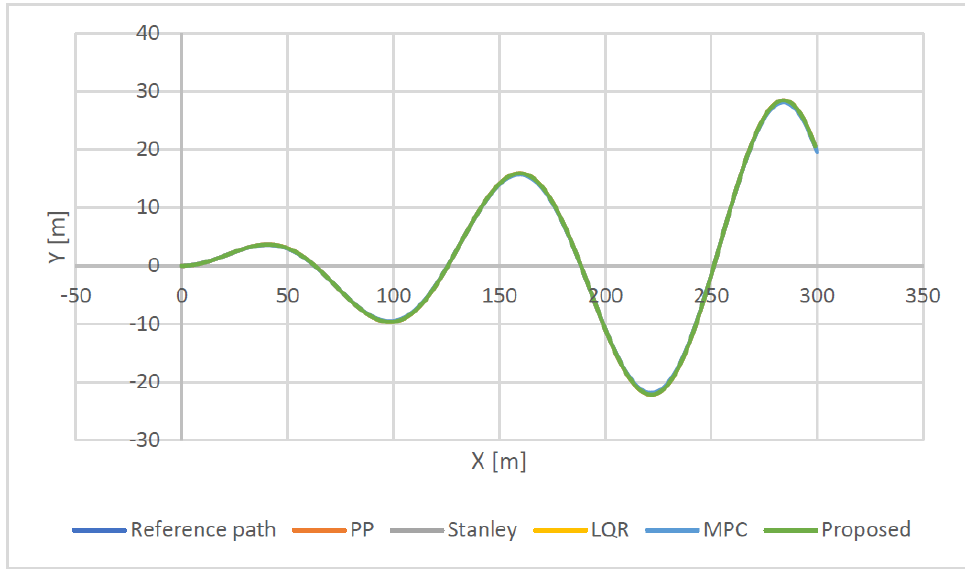
Figure 6. Tracking performance of different path tracking controllers in the simulated trajectory.